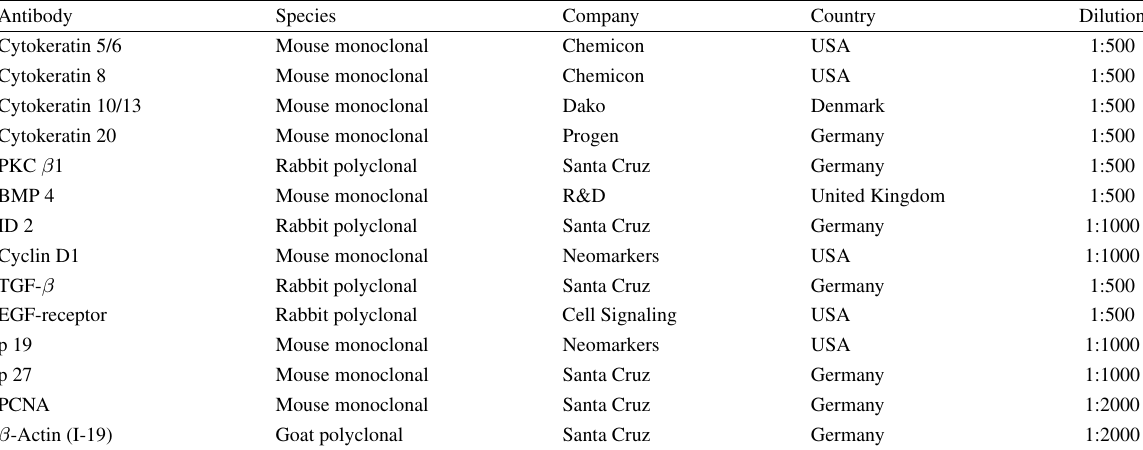
Antibodies as used for immunoblot